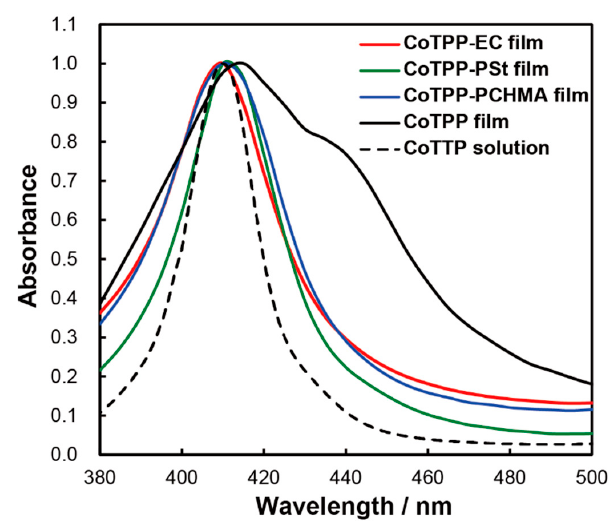
Figure 2. UV-vis absorbance spectra of CoTPP solution (black dotted line), CoTPP film (black solid line), CoTPP-EC film (red solid line), CoTPP-PSt film (green solid line), and CoTPP-PCHMA film (blue solid line) under nitrogen (N 2 ) atmosphere.